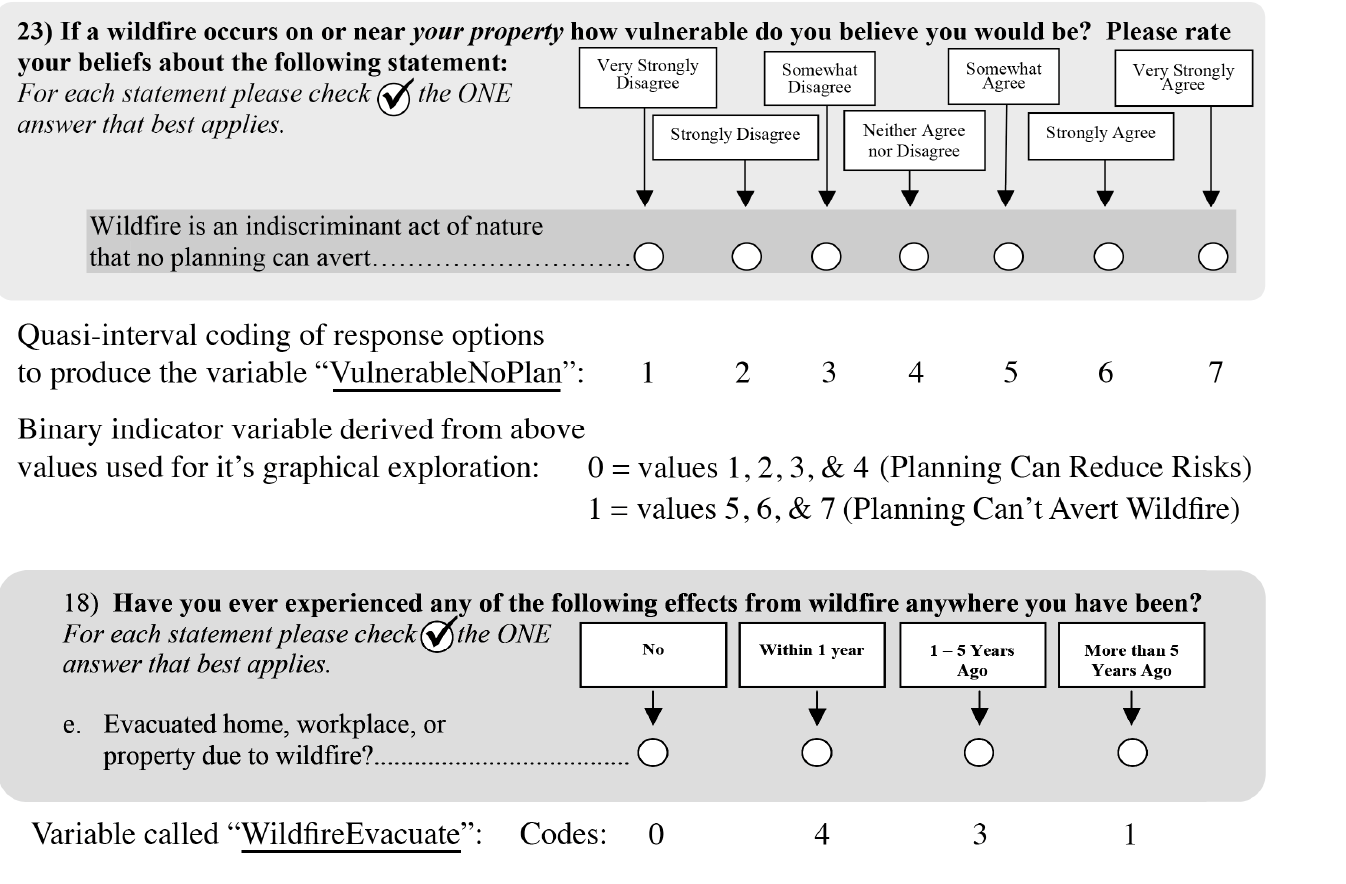
Figure 5. Survey sections querying vulnerability-agency and wildfire evacuation experience.